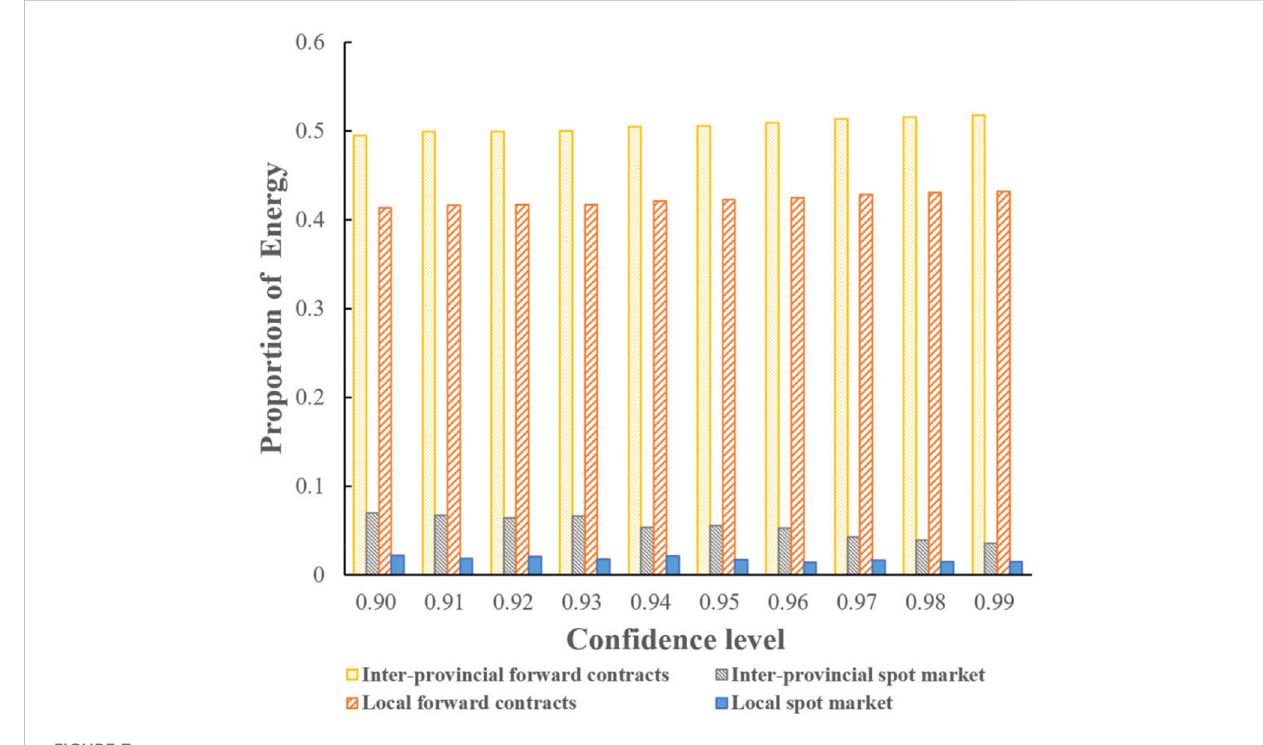
FIGURE 7 Energy portfolio of different con fi dence levels.